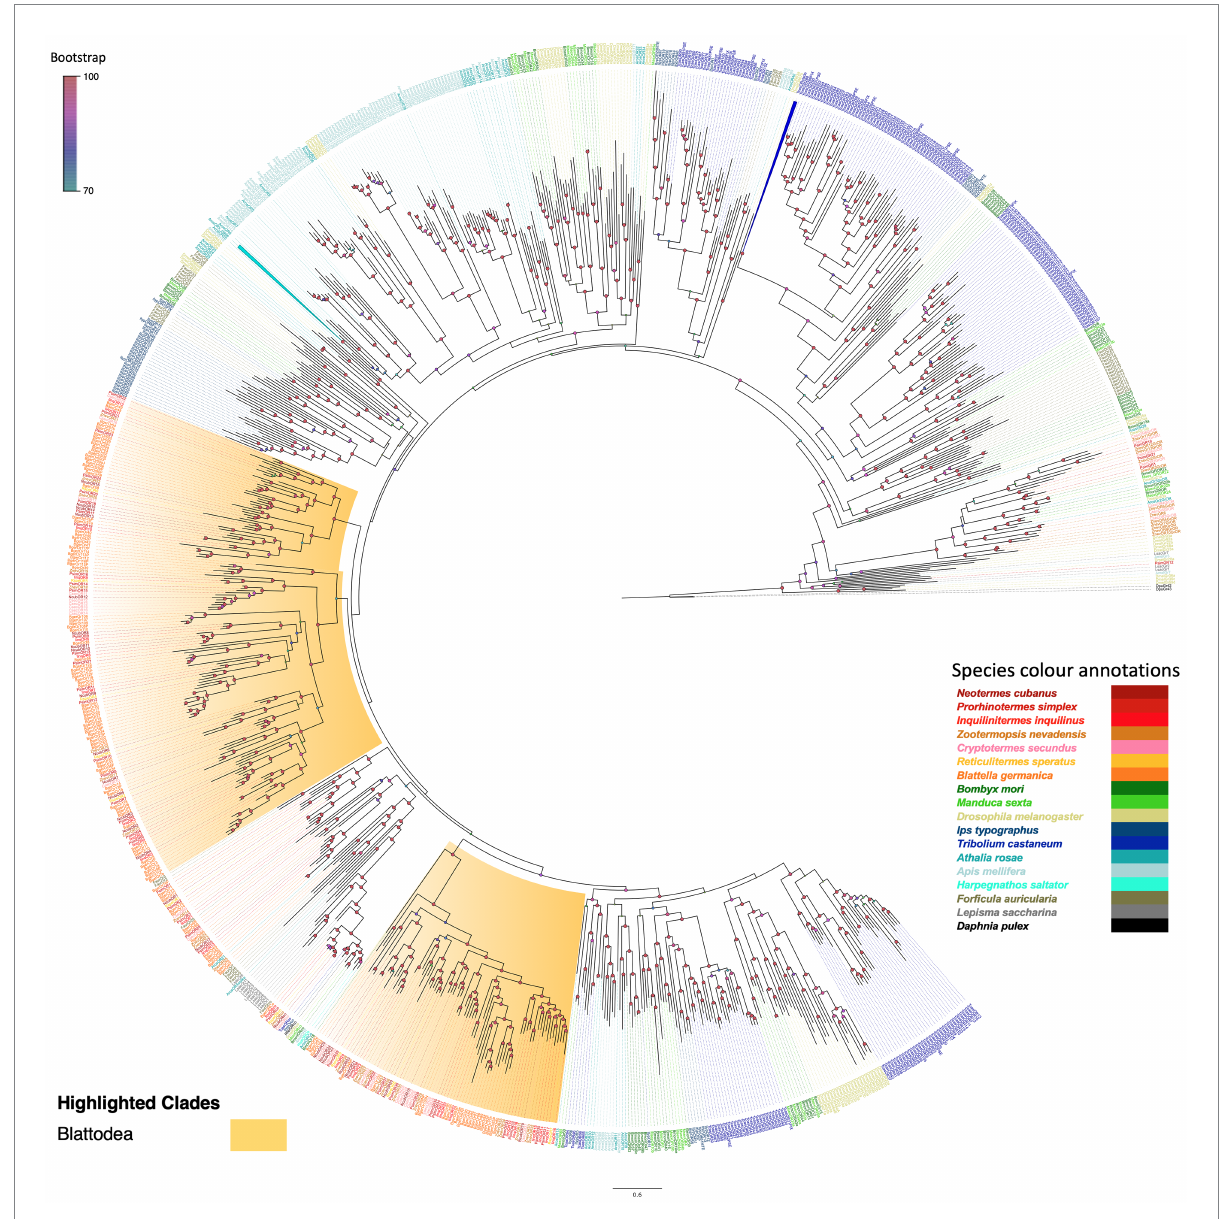
FIGURE 1 Maximum likelihood phylogeny of termite ORs. The tree was reconstructed using predicted OR sequences from termites and other insect orders and rooted using GRs as an outgroup. ORs from other species were named as follows: Blattodea: R. speratus (Rspe), C. secundus (Csec), N. cubanus (Ncub), P. simplex (Psim), I. inquilinus (Iinq), Z. nevadensis (Znev), and B. germanica (Bger); Lepidoptera: B. mori (Bmori) and M. sexta (Msex); Diptera: D. melanogaster (Dmel); Coleoptera: I. typographus (Ityp) and T. castaneum (Tcas), Dermaptera: F. auricularia (Faur) and Hymenoptera: A. rosae (Aros) and A. mellifera (Amel), H. saltator (Hsal); Outgroup: D. pulex (Dpu) and primitive ORs: L. saccharina (Lsac). Sequence names are colored according to species and color codes are provided in the in-figure legend. Node color indicates the bootstrap support value based on 1,000 replicates. The scale bar indicates the estimated amino acid substitutions per